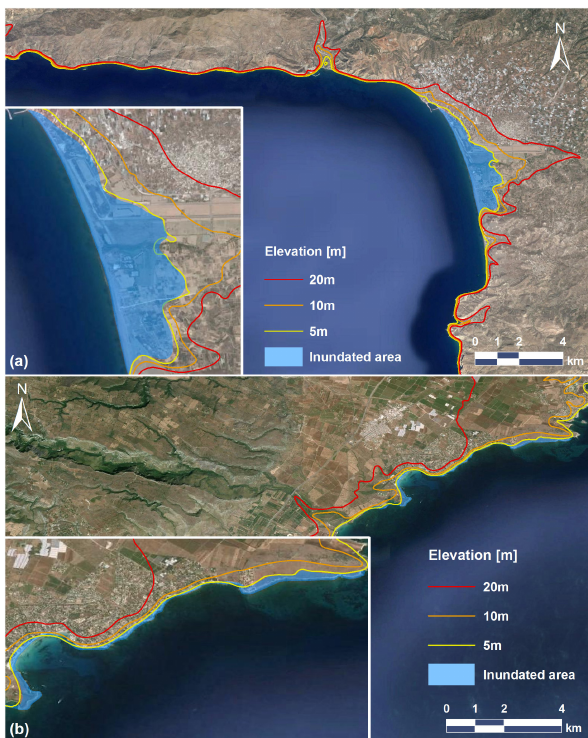
Figure 10. Inundation maps of the studied low-lying coastal areas at: (a) south-southwest Crete, and (b) east-southeast Sicily for the studied earthquake-induced tsunami scenarios (see also Figs. 6–9; base images from Google Earth, 2015; privately processed using NASA SRTM data from USGS/GDE, 2015).